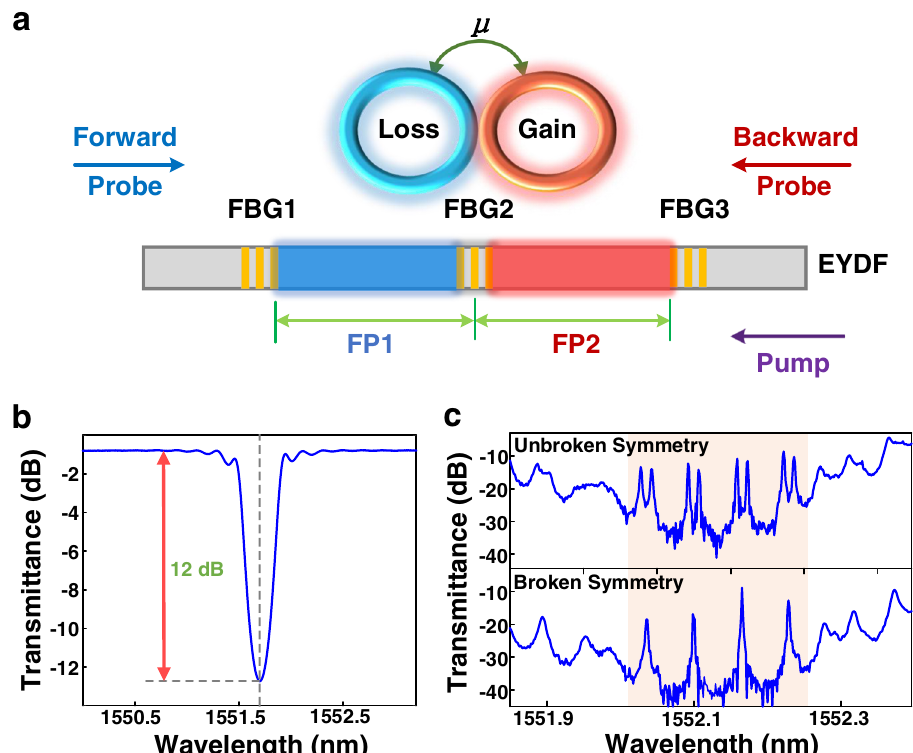
Fig. 1 Design of the all- fi ber optical nonreciprocity. a Schematic of the PT-symmetric FP resonators for nonreciprocal transmission of light. FP1 and FP2 are the two resonators with FP1 having a loss and FP2 a gain. Based on the probe input directions, forward and backward propagation con fi gurations are denoted by blue and red arrows, respectively. The purple arrow denotes the pump input direction. b Measured transmission spectrum of an individual FBG with identical fabrication parameters as those three in the PT-symmetric FP resonators. c Measured transmission spectra of the device in the unbroken PT- symmetric regime (top) and in the broken PT-symmetric regime (bottom). Resonances are observed in the re fl ection band (shaded brown) of the FBGs. FBG: fi ber Bragg grating; EYDF: erbium-ytterbium co-doped fi ber; FP: Fabry-Perot interferometer; PT: